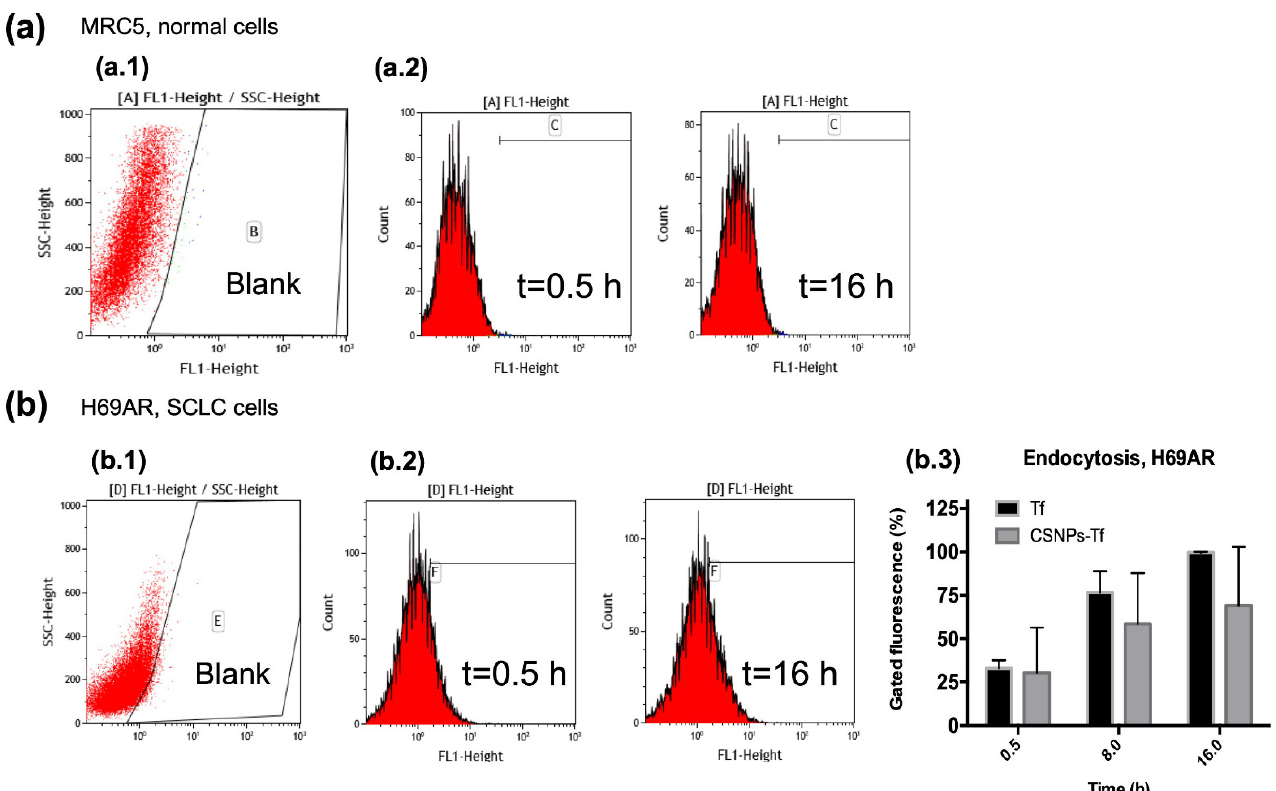
Figure 7. 1 Flow cytometry gatings for measuring the endocytic internalization in normal and SCLC cells. MRC5 and H69AR cells were incubated with Tf-AF488 (Tf) conjugated and CSNPs-Tf-AF488 conjugated (CSNP-Tf). Tf-AF488 was used as a positive control to measure the maximum fluorescence value of endocytosis in both cell lines. Cells were incubated at 37 °C to allow internalization of Tf-AF488 and the CSNP complex at t = 0.5, 8, and 16 h. ( a.1 ) Cells were first gated by side scatter versus forward scatter in a blank sample. ( a.2 ) Representative profiles of t = 0.5 h and t = 16 h of internalization of the CSNP complex in a control cell line (MRC5); we observed that fluorescence (endocytosis level) is the same in blanks and t = 0.5 and 16 h. ( b.1 ) Cells were first gated by side scatter versus forward scatter in a blank sample. ( b.2 ) Representative profiles of t = 0.5 h and t = 16 h of the CSNP complex in the SCLC cell line (H69AR), we observed that fluorescence (endocytosis level) is different t = 0.5 and t =16 h, in ( b.3 ) the graph shows the change of the gated percentage of fluorescence of Tf-AF488 (black bars) and the CSNP complex (gray bars) versus time, the expression of the data as the means ±